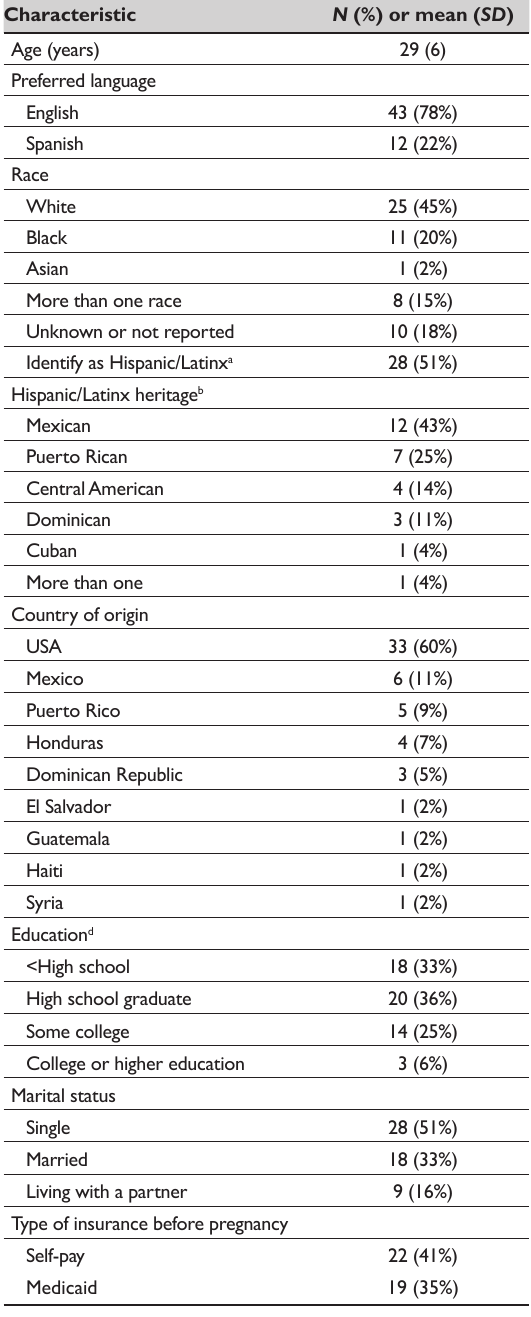
Table 1: Sociodemographic characteristics